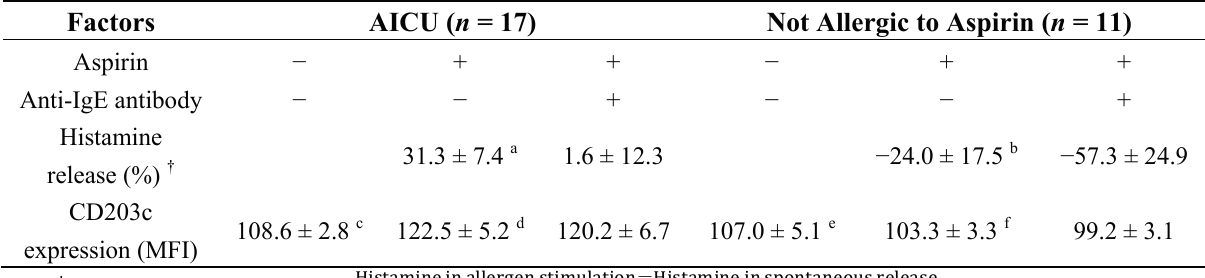
Table 3. Differences in basophil activation activity in sera between the subjects with AICU and those not allergic to aspirin.